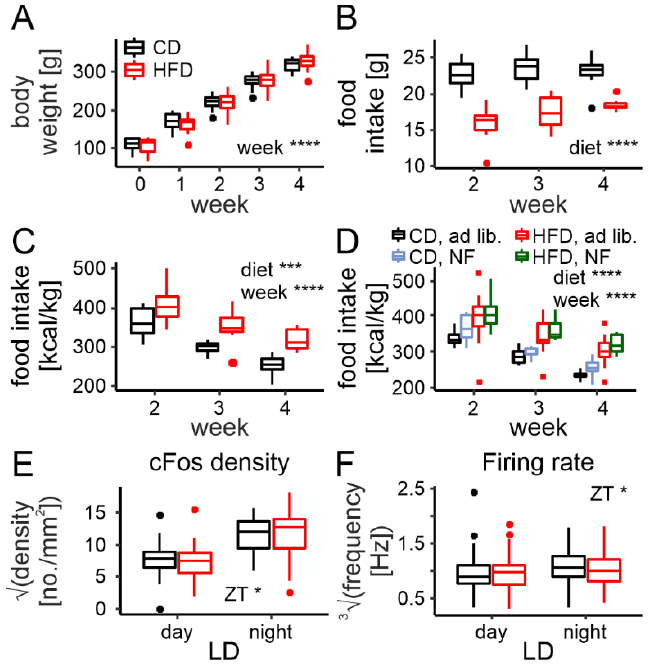
Figure 5. Rhythm disruption in cFos immunoreactivity and neuronal activity are prevented by night feeding (NF). ( A ). Body weight gain across 4 weeks (including 2 weeks on restricted nighttime feeding) on either control (CD) or high-fat diet (HFD; diet: F1,14 = 0.0001, p = 0.99, week: F4,14 = 629.74, p < 0.0001, interaction: F4,14 = 1.66, p = 0.22). ( B ). Nighttime-restricted food intake in grams for CD and HFD (diet: F1,14 = 56.28, p < 0.0001, week: F2,14 = 3.56, p = 0.056, interaction: F2,14 = 1.91, p = 0.18). ( C ). Nighttime-restricted food intake in kcal/kg body mass across the 2 week period (diet: F1,14 = 19.14, p = 0.00063, week: F2,14 = 33.71, p < 0.0001, interaction: F2,14 = 0.44, p = 0.66). ( D ). Comparison of total daily food intake between ad libitum and NF protocols for both diets (diet: F1,32 = 30.89, p < 0.0001, week: F2,64 = 69.14, p < 0.0001, protocol: F1,32 = 3.46, p = 0.072). ( E ). Comparison of cFos immunoreactivity and its changes between midday and midnight (LD — light/dark) between rats fed either CD or HFD during nighttime only (diet: F1,6 = 0.017, p = 0.9, LD: F1,6 = 10.11, p = 0.019, interaction: F1,6 = 0.023, p = 0.88. ( F ). Comparison of the neuronal firing rate and its changes between midday and midnight between rats fed either CD or HFD during nighttime only (diet: F1,12 = 0.1, p = 0.75, LD: F1,12 = 5.56, p = 0.037, interaction: F1,12 = 0.47, p = 0.51. * p < 0.05, *** p < 0.001, **** p < 0.0001. Box-and-whisker plots present the median value, the interquartile range (IQR; box) and the minimum-to-maximum range of values, not exceeding 1.5 * IQR (whiskers). Data points outside this range are plotted individually as outliers.